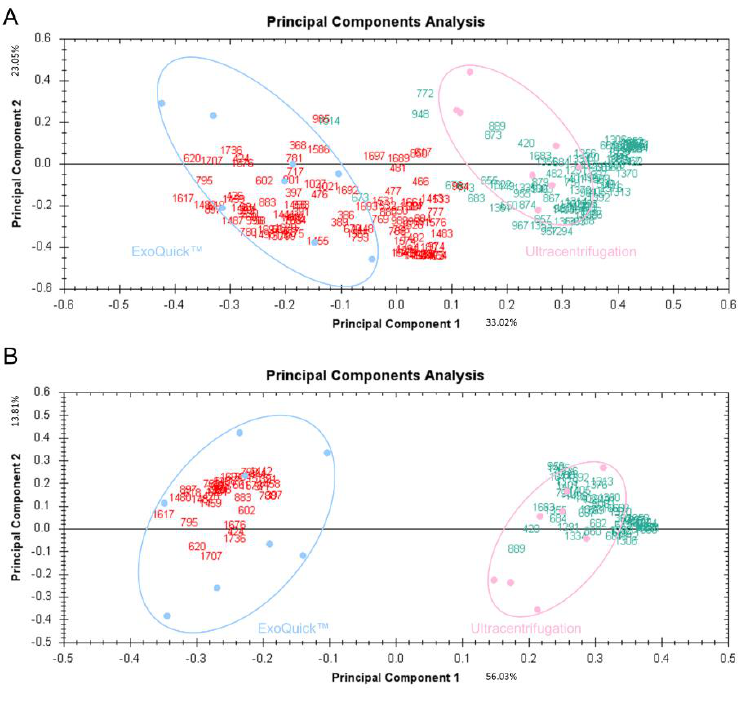
New corrected Figure 2 for replacement: